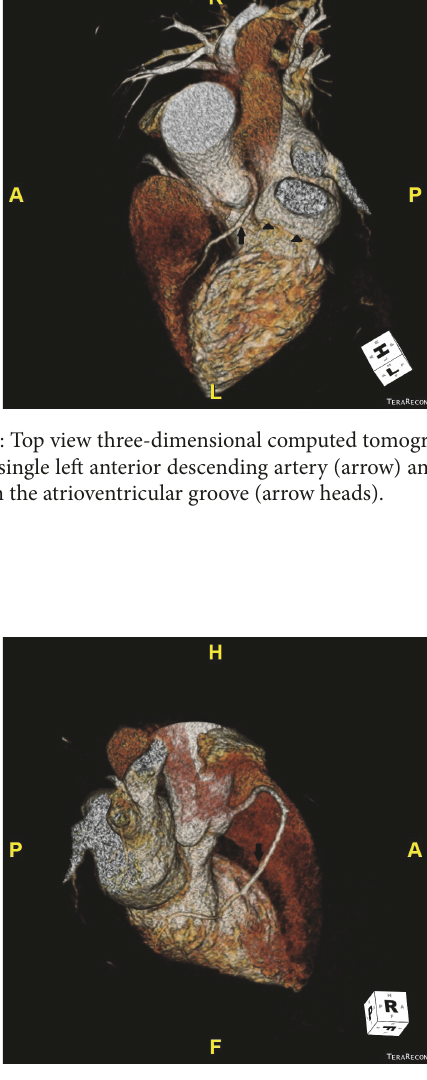
Figure 5: Inferior view three-dimensional computed tomography scan showing large dominant right coronary artery